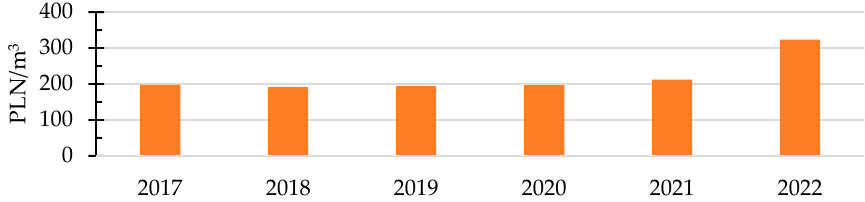
Figure 1. Average annual log prices in Poland in 2017–2022 (data source: Statistics Poland [8]). The direction of softwood lumber price changes is similar to that of the log price changes, as shown in Figure 2.